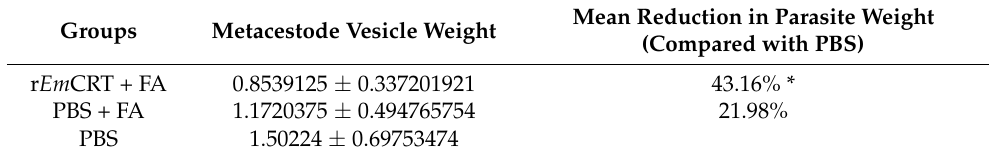
Table 1. Alveolar echinococcus weight in mice.